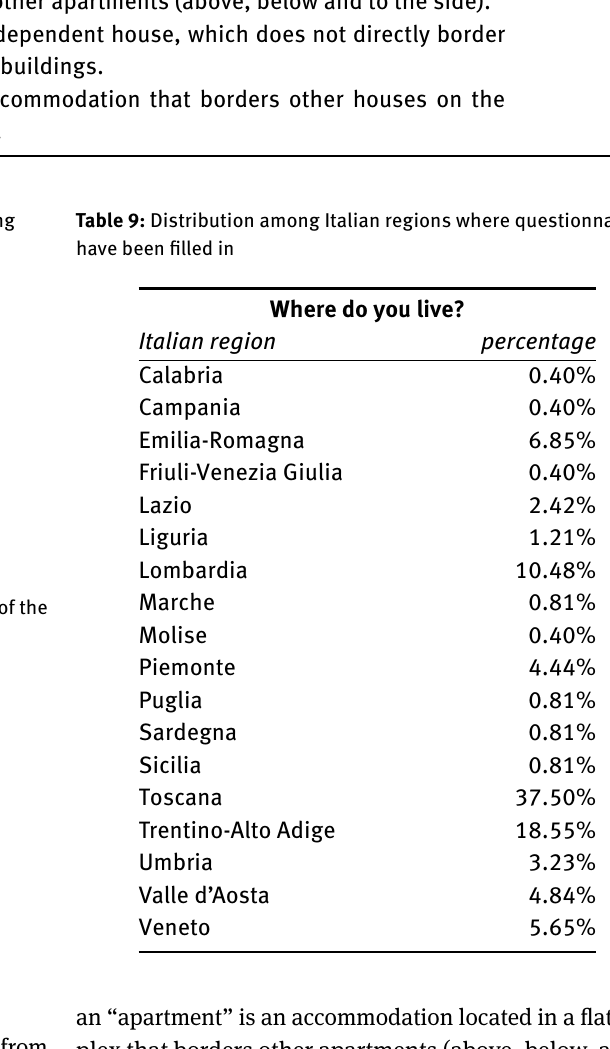
Table 6: Frequency distribution of the type of dwelling where the subjects live in What type of house do you live in? options in English/Italian ders other apartments (above, below and to the side).